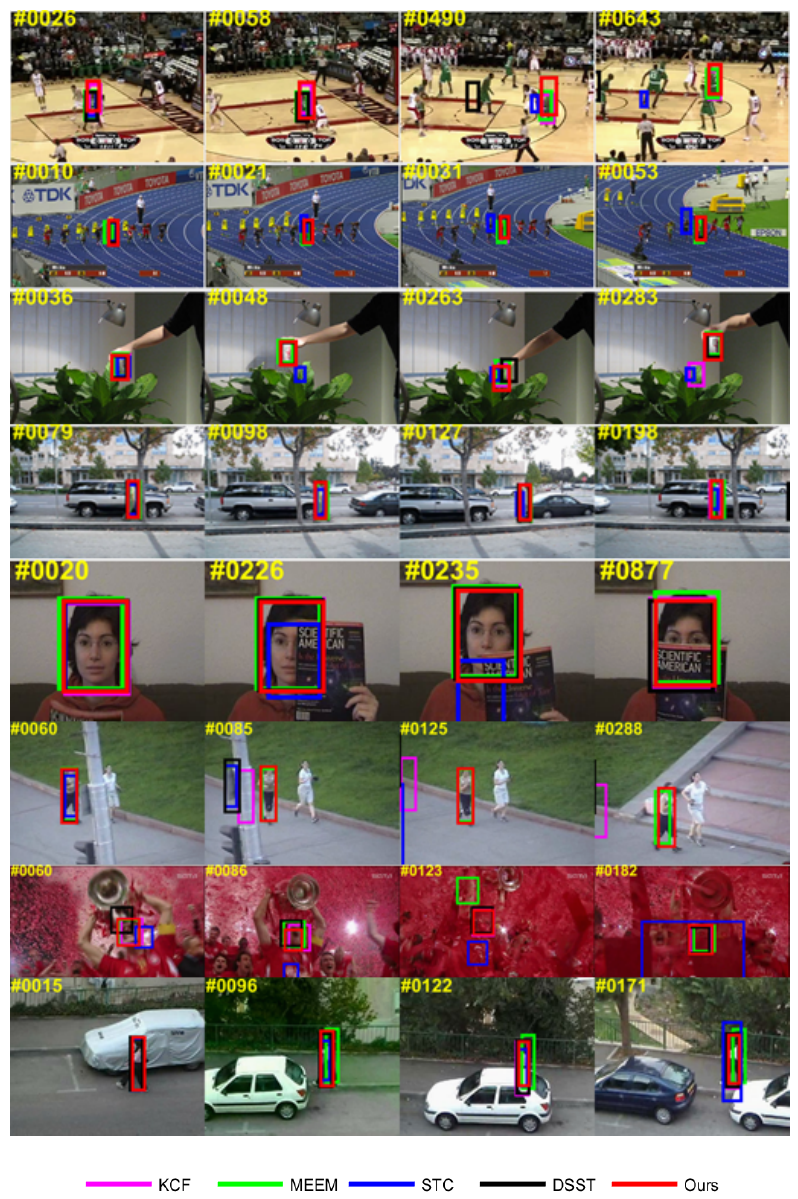
Figure 6. Qualitative evaluation of our approach in comparison with four state-of-the-art trackers. Tracking results for eight challenges of occlusion sequences ( Basketball, Bolt, coke, David3, Faceocc1, Jogging1, Soccer, and Woman ) from the OTB100 dataset are shown. Our approach outperforms the state-of-the-art trackers in these occlusion